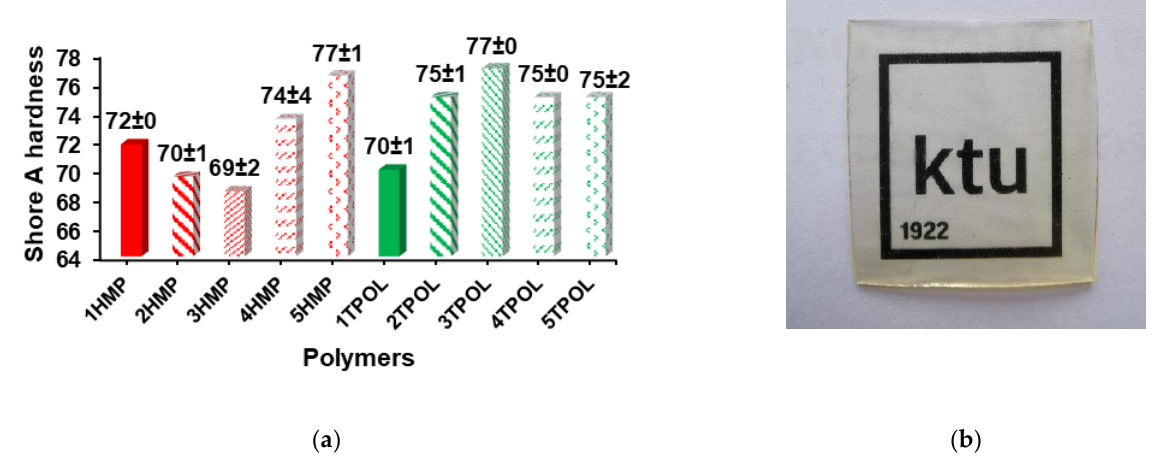
Figure 6. ( a ) Shore A hardness of AESO thiol – ene polymers, ( b ) Photograph of polymer 3TPOL.